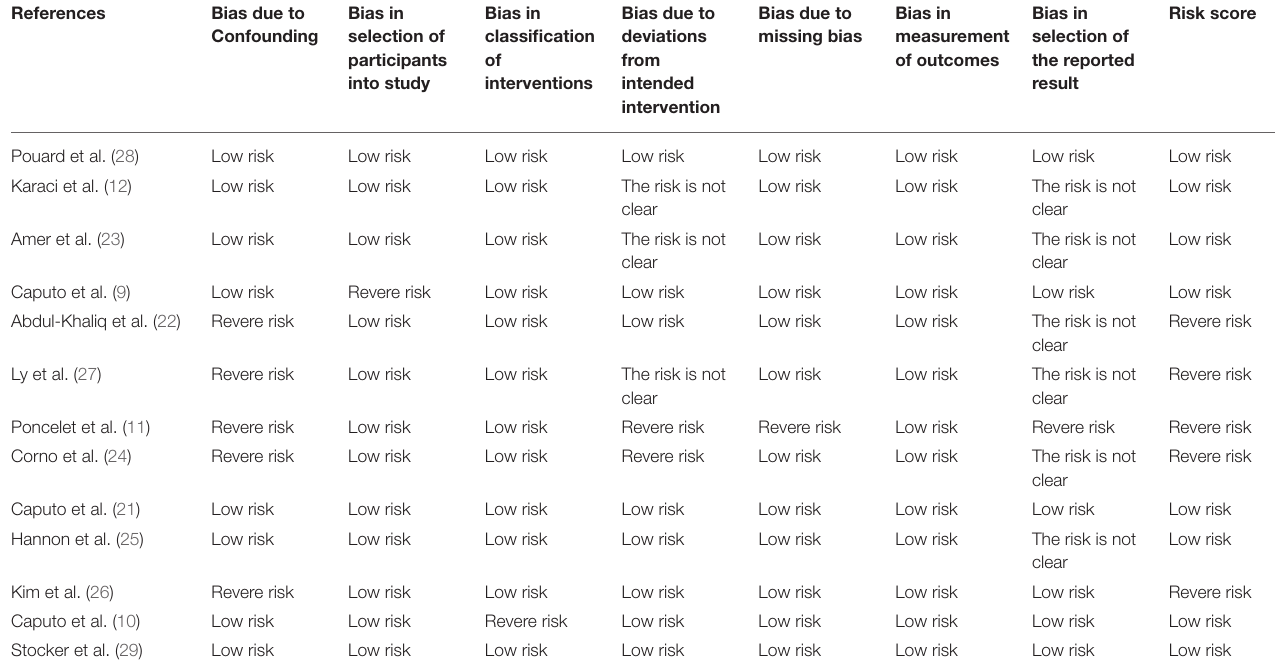
TABLE 3 | Quality